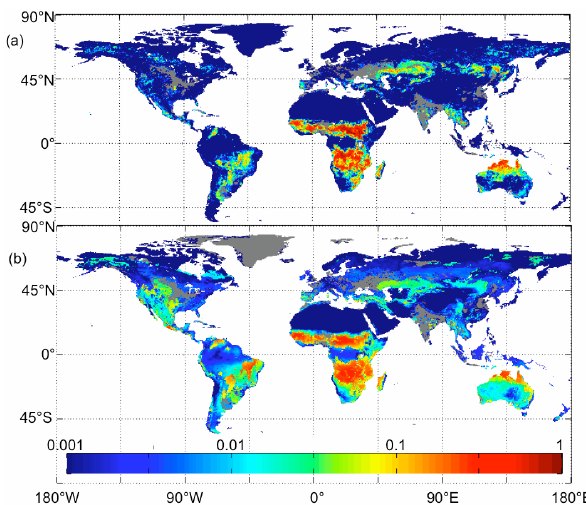
Fig. 3. Observed (a) and modelled (b) mean fire frequency (1 yr − 1 ) for MCD45 burned-area data. Model results are with optimised parameters and the standard 8 regions.